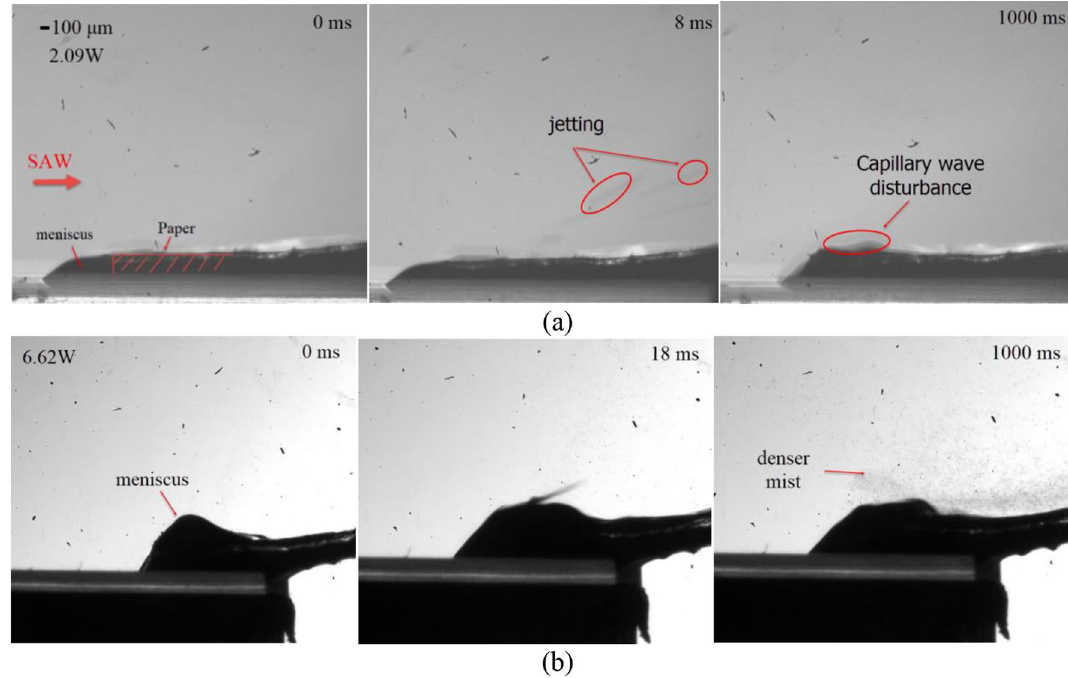
Figure 9. Atomization process at different input power with working frequency of 60 MHz. ( a ) 2.09 W; ( b ) 6.62